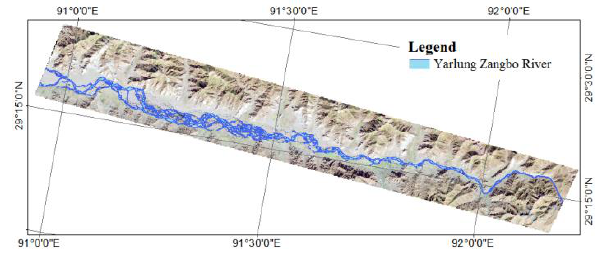
Figure 12. Extraction result of midstream in 2015